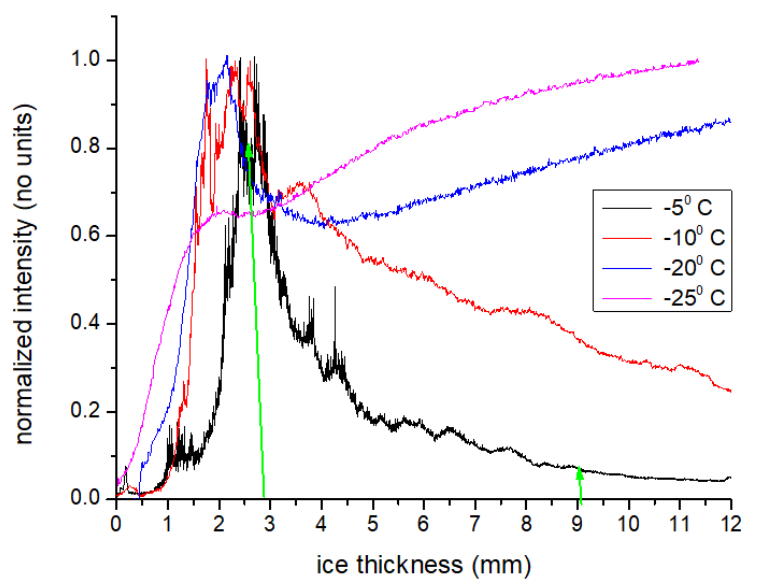
Figure 13. Typical normalized ice growth curves of the inner signal fiber 4 obtained at temperatures of − 5 °C to − 25 °C.